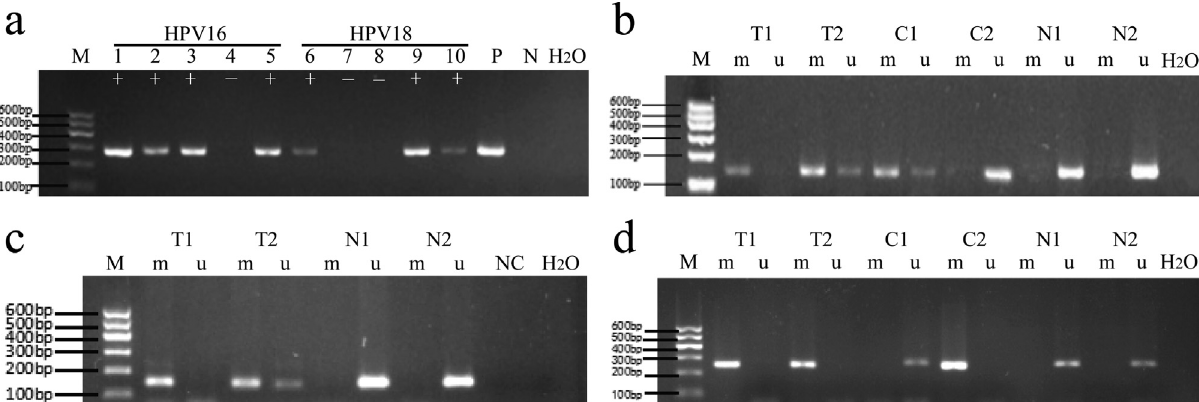
Figure 1 - Infection with high-risk human papillomavirus (hr-HPV) and methylation of WT1, NKX6-1 and DBC1 genes in different stages of cervical le- sions by agarose gel electrophoresis. (A) HPV16/18 infection; (B) WT1 methylation; (C) NKX6-1 methylation; (D) DBC1 methylation. M: marker (100 ~600bp);lanes1-5:HPV16virusPCRproducts;lanes6-10:HPV18virusPCRproducts;P:positivecontrol,N:negativecontrol;+:positive,-:negative. M: methylation-specific PCR products; U: unmethylation-specific PCR products; T: cervical cancer tissue; C: cervical intraepithelial neoplasia lesions; N: normal cervical tissue.